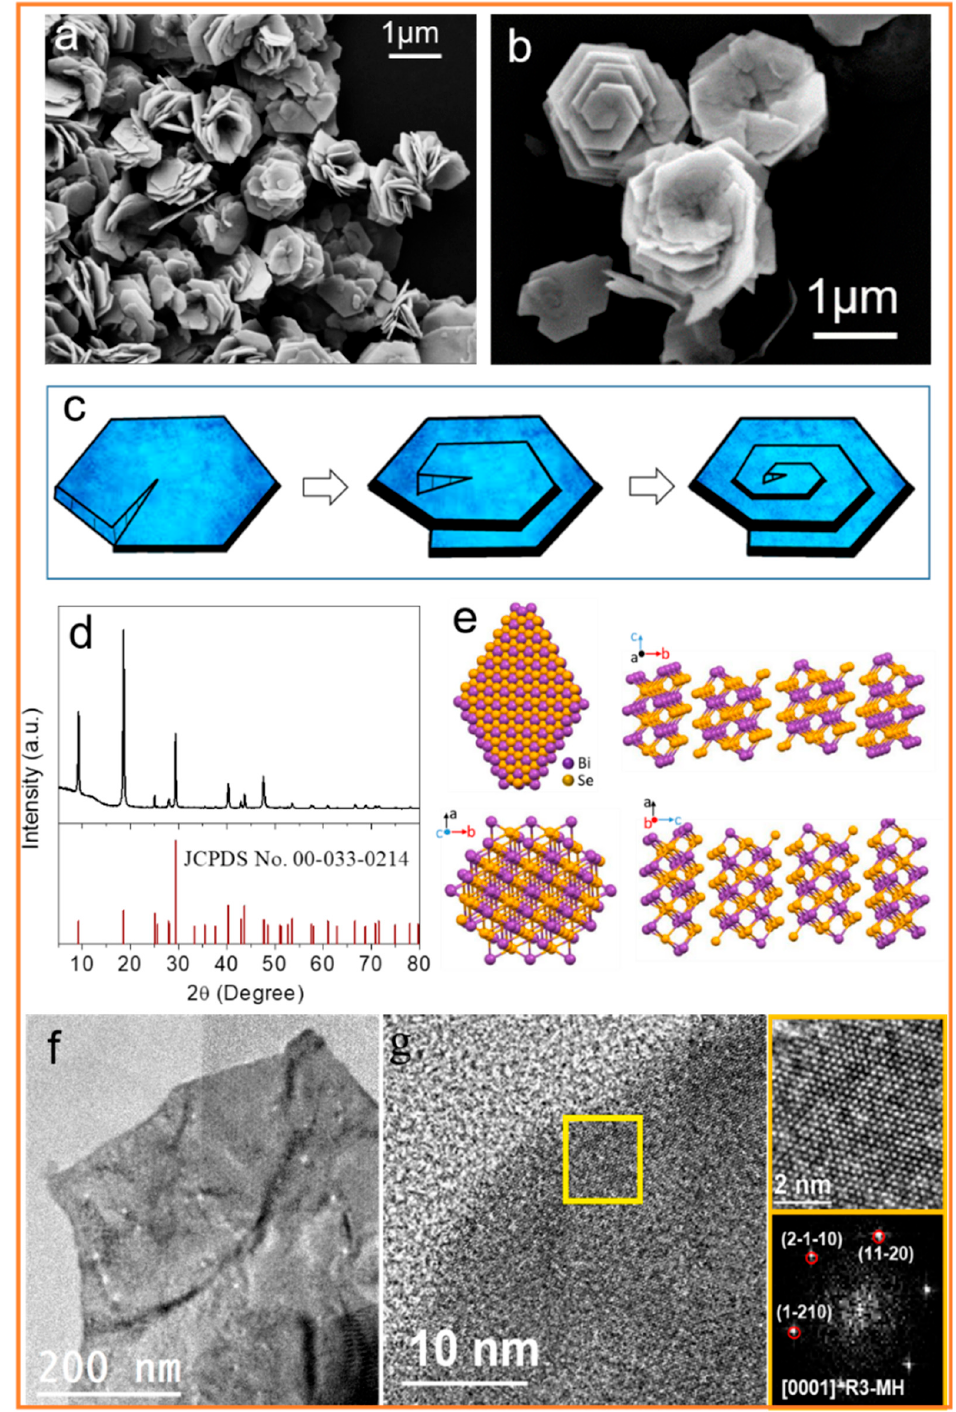
Figure 1. ( a , b ) SEM micrographs of the Bi 2 Se 3 particles. ( c ) Scheme of the screw dislocation growth mechanism. ( d ) The XRD pattern of the Bi 2 Se 3 particles. ( e ) The layered rhombohedral crystal structure of Bi 2 Se 3 . ( f ) A low ‐ resolution TEM image. ( g ) An HRTEM micrograph of the Bi 2 Se 3 particles and its corresponding power spectrum. From the crystallographic domain, the Bi 2 Se 3 lattice fringe distances were measured to be 0.205 nm, 0.205 nm, and 0.204 nm, at 60.96° and 120.86°, respectively, which could be illuminated as the rhombohedral Bi 2 Se 3 phase, visualized along the [0001] zone axis.